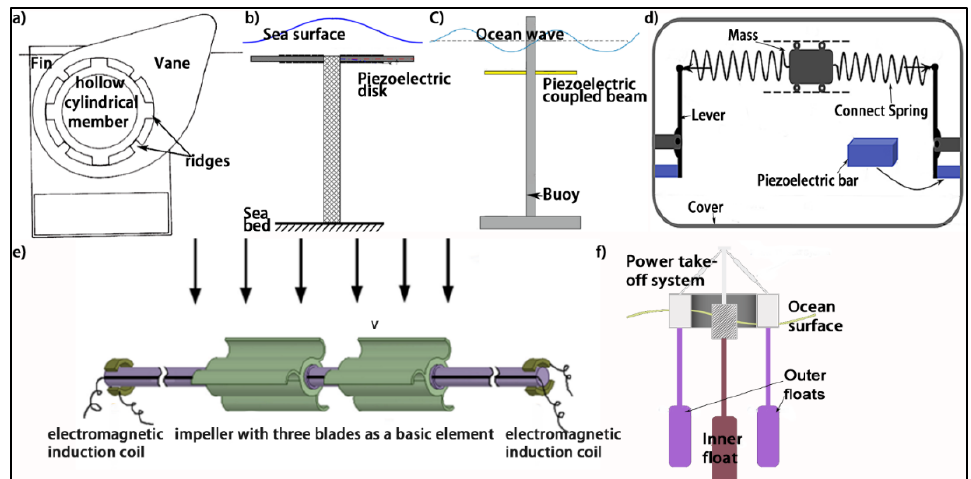
Figure 6. Medium-scale energy harvesters of liquid flow. ( a ) Rotating vane shape energy converter (reproduced with permission [62]. Copyright 1974, Nature Publishing Group). ( b ) Piezoelectric converter for deep ocean energy harvesting (reproduced with permission [63]. Copyright 2014, Elsevier). ( c ) Piezoelectric converter for buoy harvester (reproduced with permission [64]. Copyright 2015, Elsevier). ( d ) Mass-spring system for deep ocean energy harvesting (reproduced with permission [65]. Copyright 2016, Elsevier). ( e ) Three-blade impeller electromagnetic energy harvester (reproduced with permission [66]. Copyright 2017, Elsevier). ( f ) One-degree of freedom model with switched linear system (reproduced with permission [67]. Copyright 2010, Elsevier).